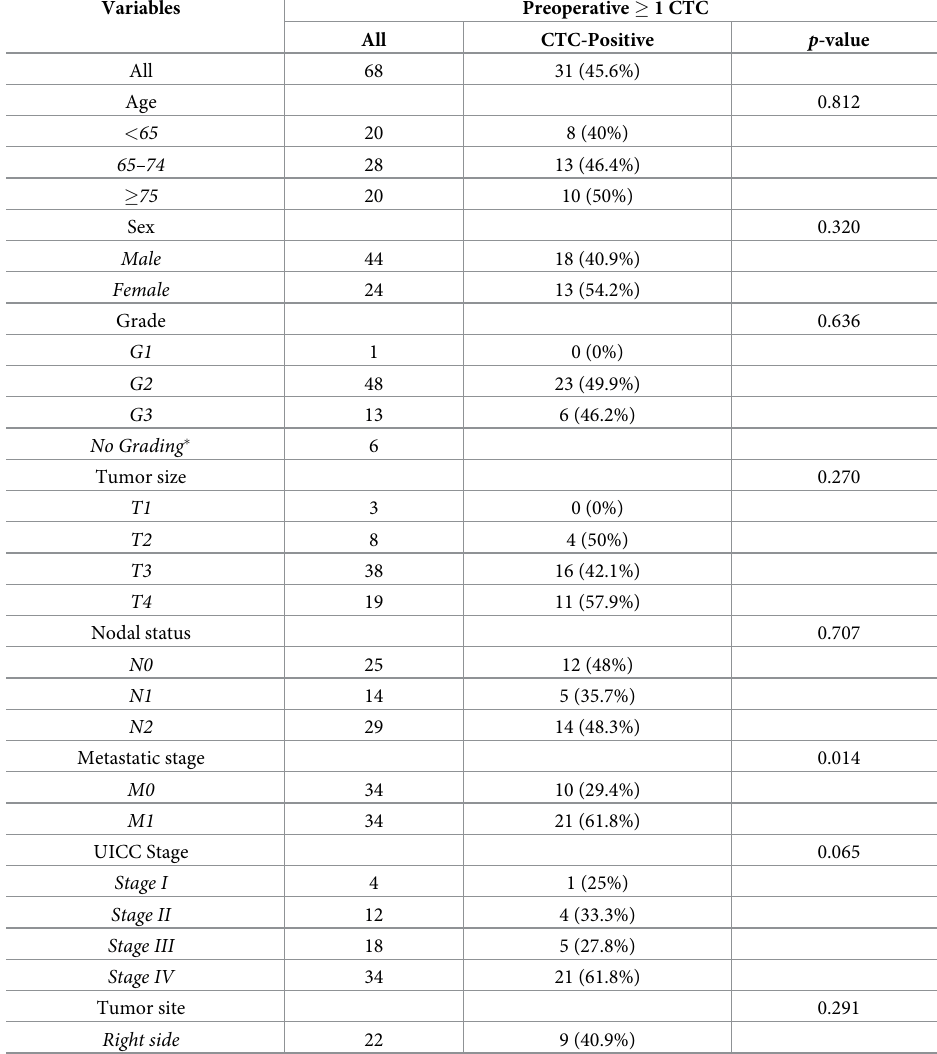
Table 2. Patient characteristics and correlation of CTCs at baseline with clinicopathological